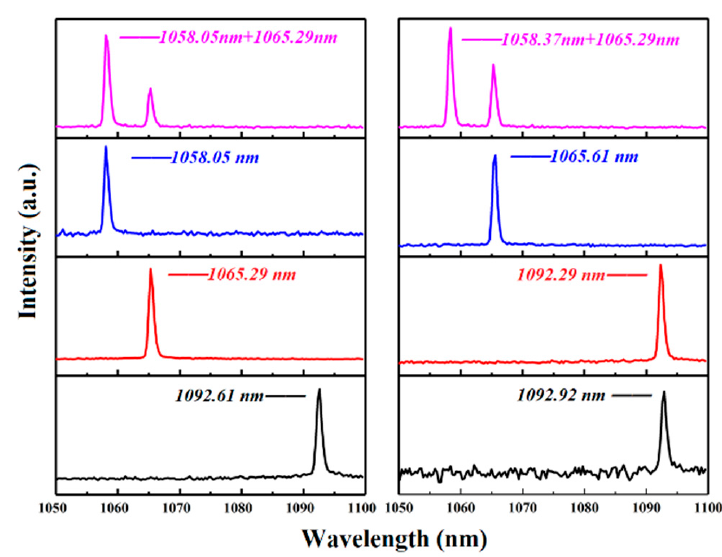
Figure 4. Typical output spectra of the tunable Nd:GLNO laser with T = 1%. Table 1. Output parameters of the tunable Nd:GLNO crystal laser. T